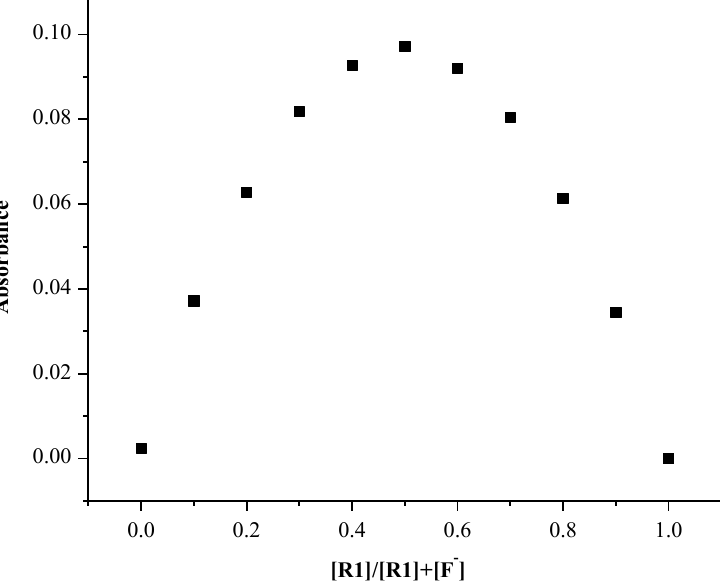
Figure 9. Job’s plot between sensor R1 and fluoride ion.